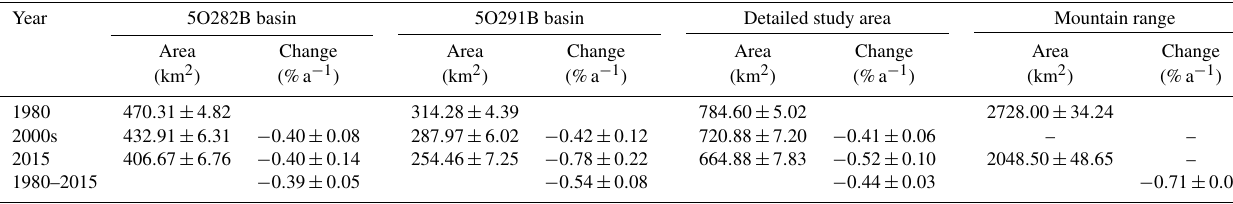
Table 3. Glacier area changes in the Kangri Karpo from 1980 to 2015. 5O291B basin Detailed study area Mountain range